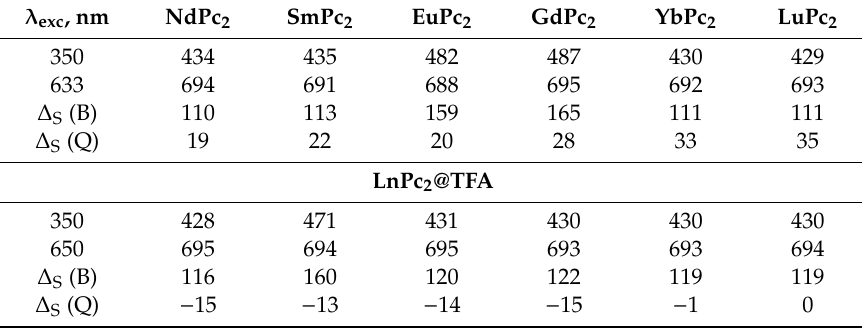
Table 4. Fluorescence emission spectral data; wavelengths (nm) referring to the emission maxima are shown for the base LnPc 2 compounds and for their TFA conjugates; excitation was performed using laser radiation of 350, 633, and 650 nm; Stokes shift, ∆ S (nm), calculated relative to the λ max value of the B and Q bands, ∆ S (B) and ∆ S (Q), respectively. λ exc , nm NdPc